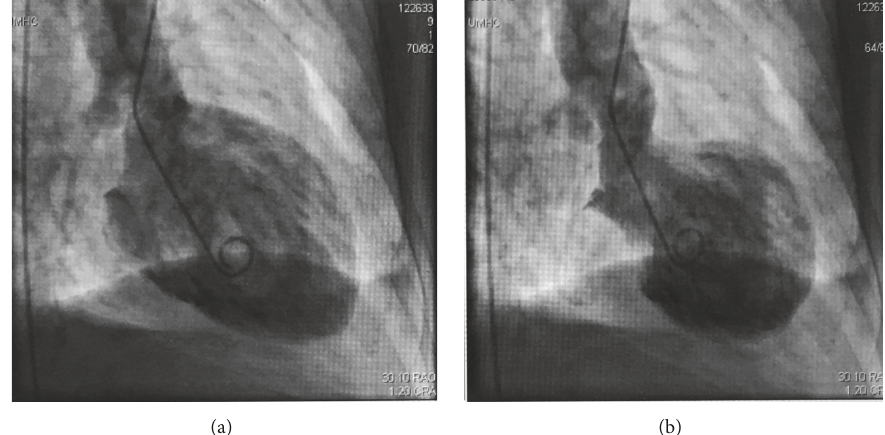
Figure 2: Left ventriculogram in RAO projection in diastole (a) demonstrates normal cavity contour and in systole (b) preserved basal and apical contractility with akinesia of the mid ventricle consistent with Takotsubo stress cardiomyopathy.